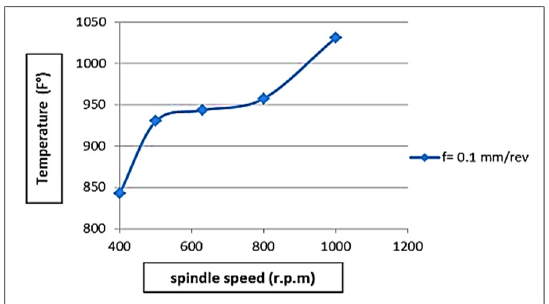
Fig. 8. Graphical method .